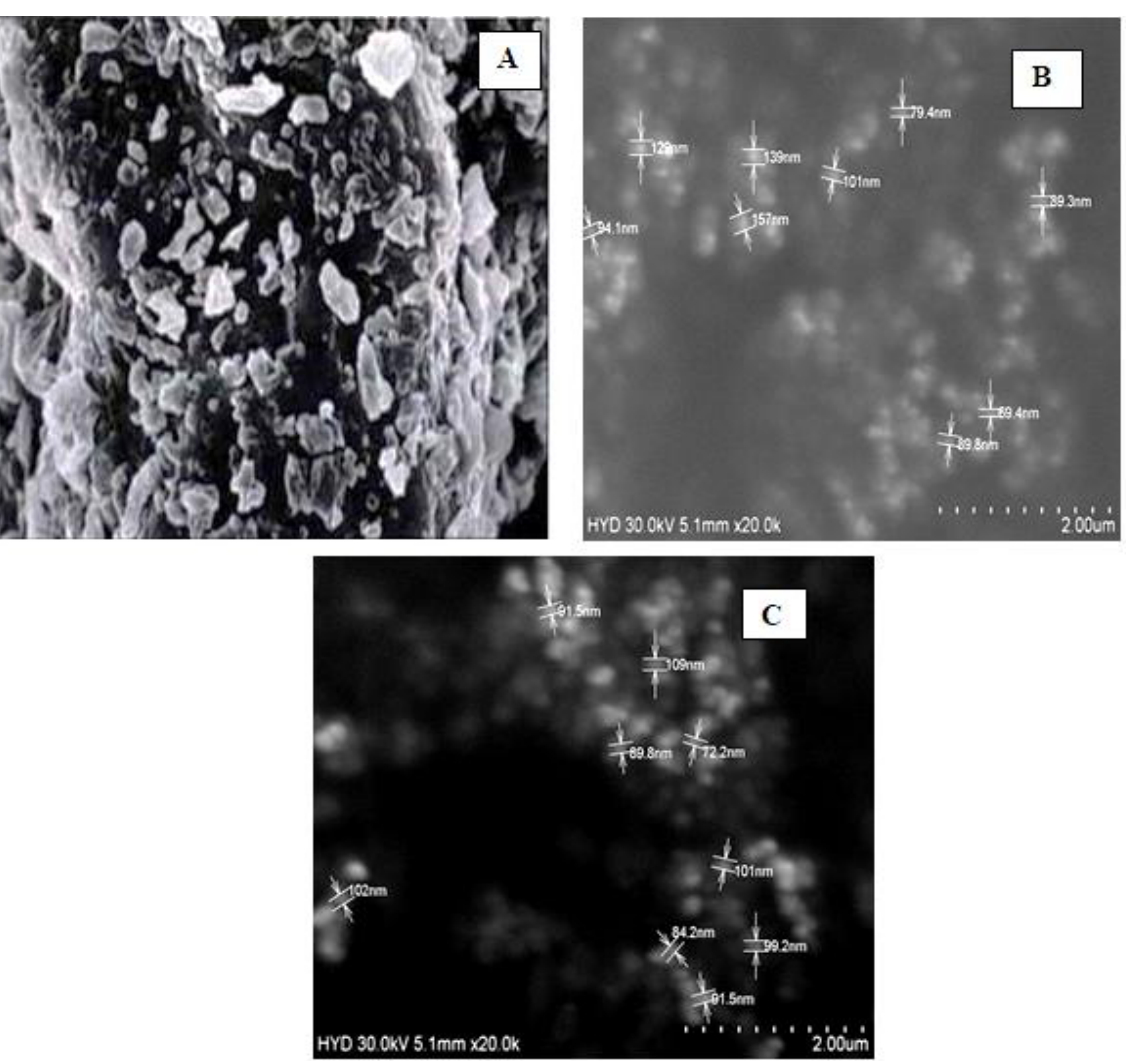
Figure 4. SEM images of ( A ) Ciprofloxacin hydrochloride ( B ) β -TCP ( C ) Nanocarriers ’ formula- tion.